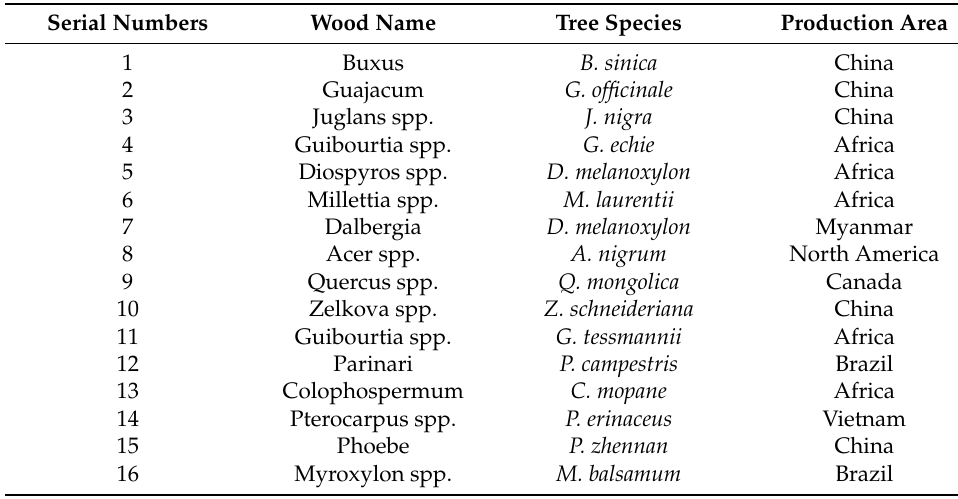
Figure 1. Wood specimens investigated in this work. Table 1. Basic information of the twenty tree species.